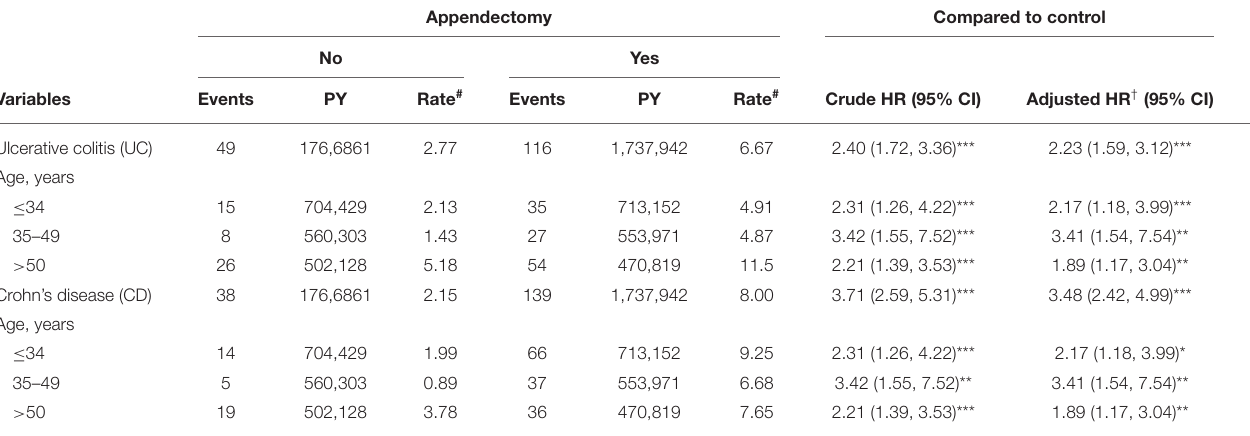
TABLE 5 | Comparison of the HR for ulcerative colitis and Crohn’s disease among patients who underwent appendectomy at different ages. Appendectomy Compared to